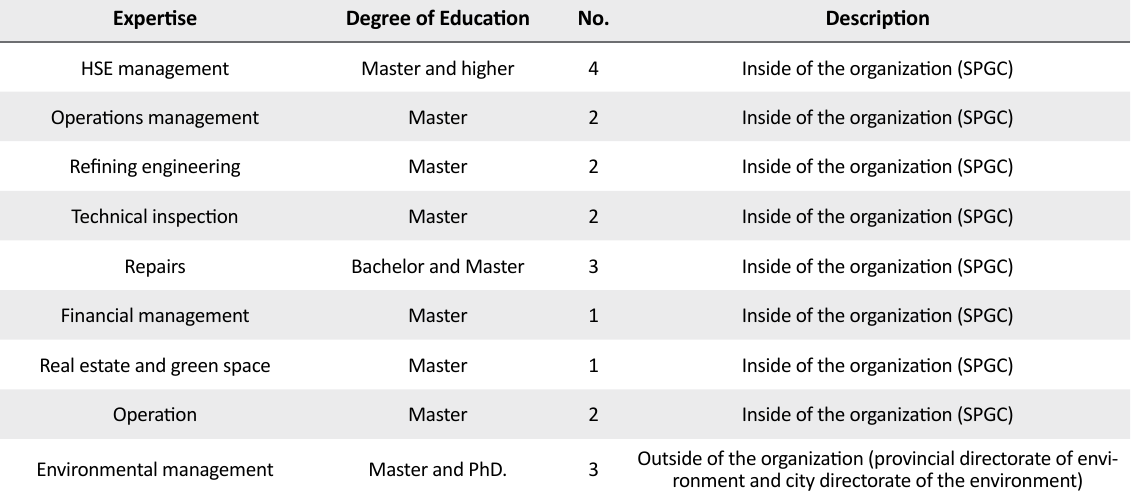
Table 1. Characteristics of experts in the research sample Expertise